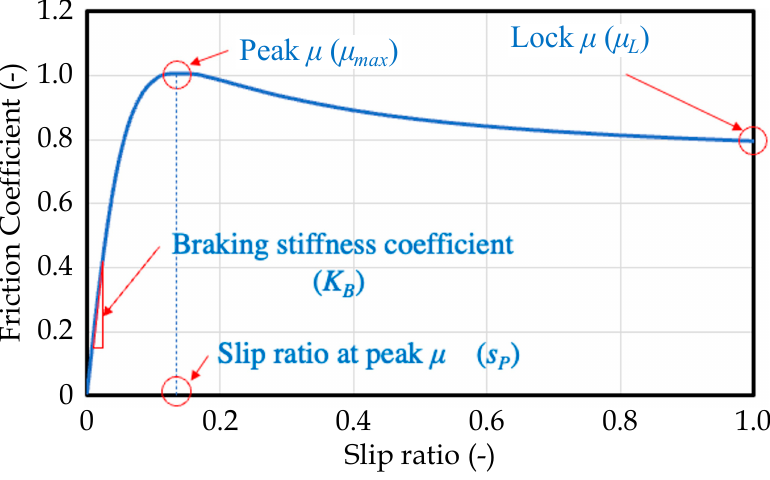
Figure 4. Important characteristics of road friction. On wet roads, it seems that the peak µ is also reduced compared to dry surfaces, but this change is not big enough to affect road traffic safety. The reason for this is that an adhesion region and a sliding region are generated in the contact patch of the tire. The friction in the adhesive area is static and can be used up to the maximum static